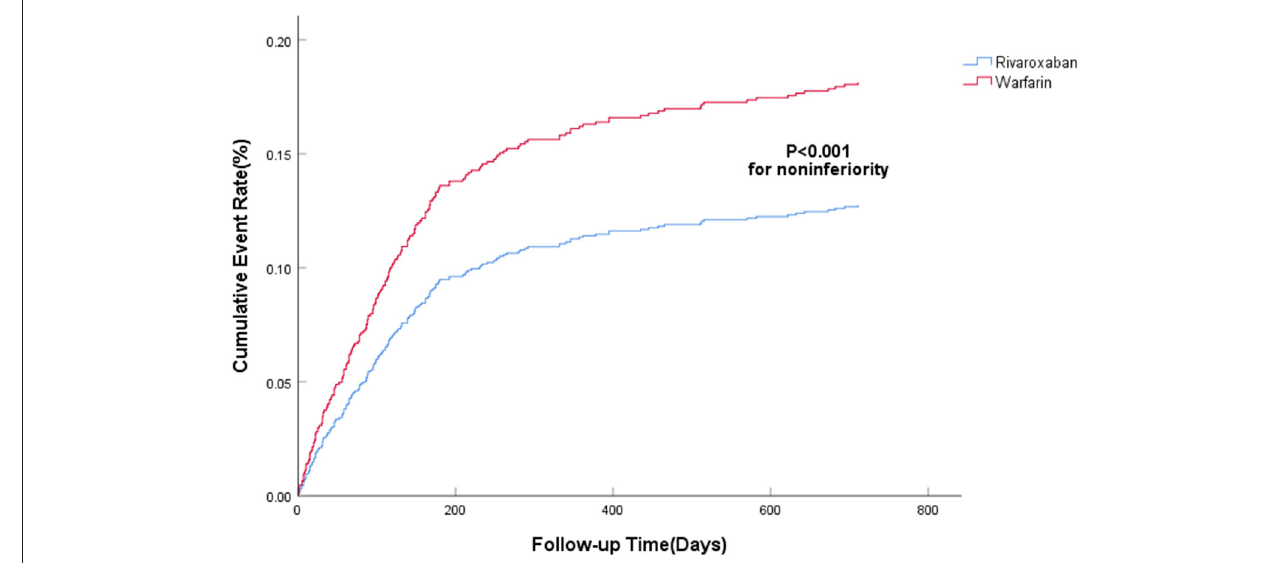
FIGURE 1 | The primary efficacy benefit end point.